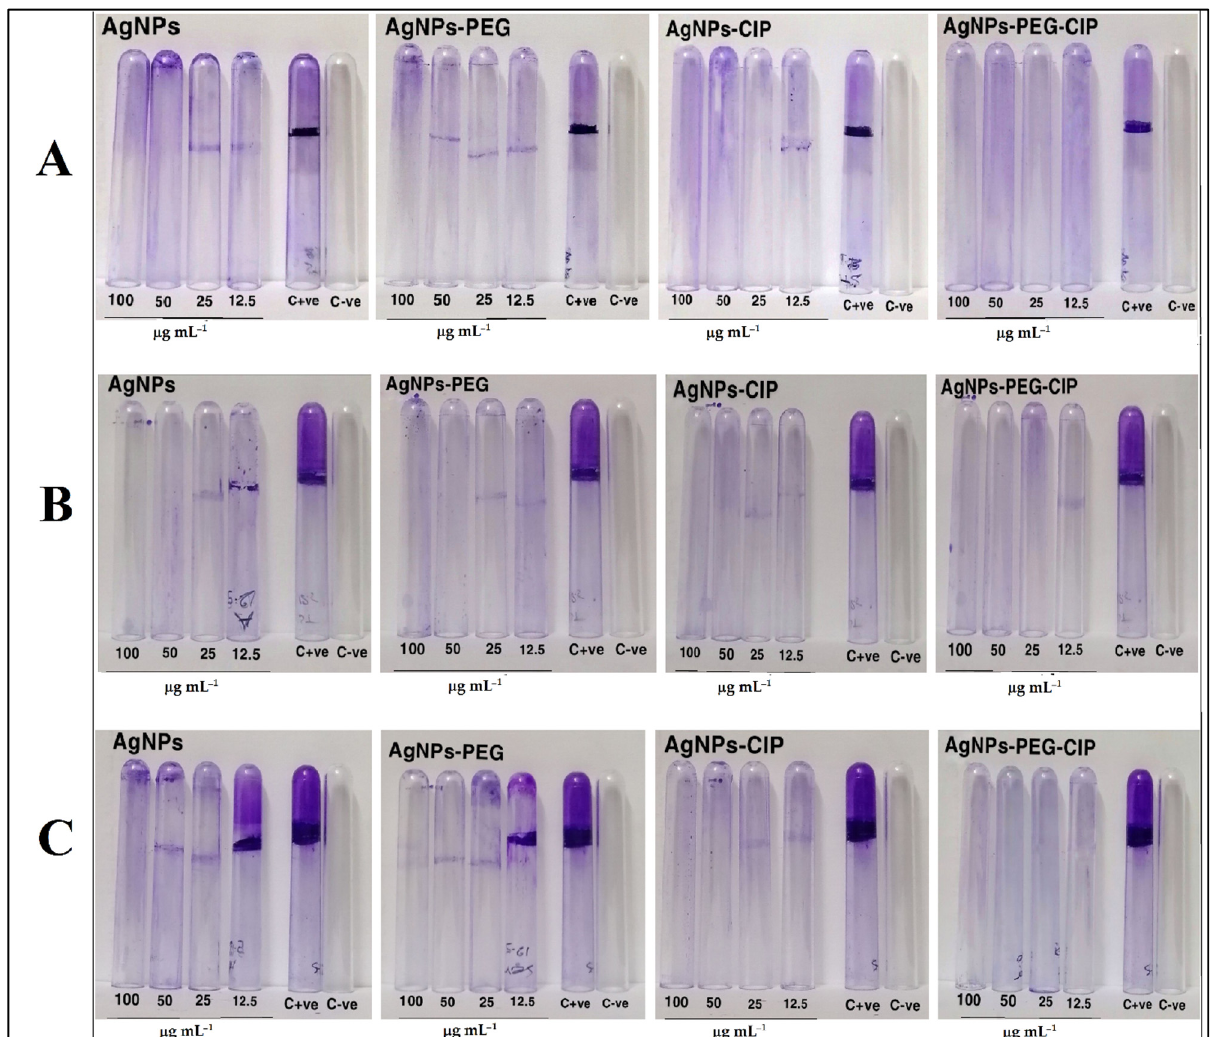
Figure 14. The anti-biofilm effects of AgNPs and their conjugates at 12.5, 25, 50, and 100 µ g mL − 1 concentrations by ( A ) S. aureus , ( B ) A. baumannii , and ( C ) S. Table 2. Effect of AgNPs and their conjugates on the biofilm produced by the tested bacteria.